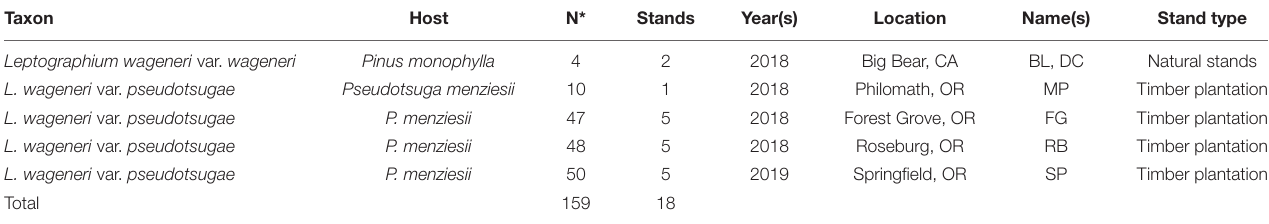
TABLE 1 | Summary of Leptographium wageneri taxa, isolates, and sampling locations.